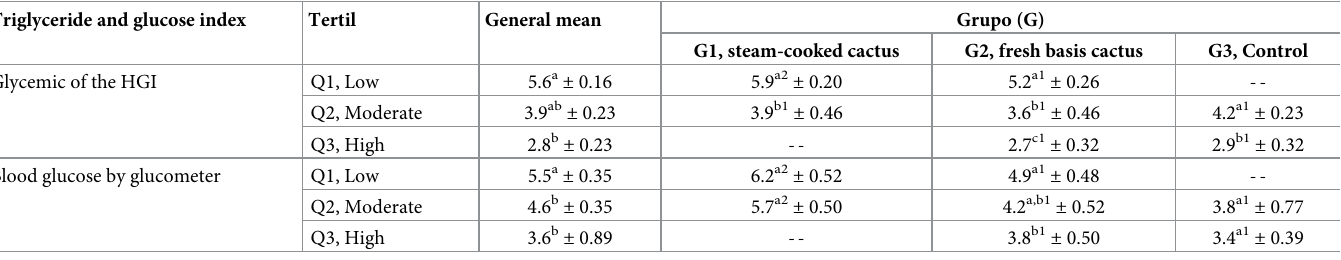
� = Commercial feed plus cactus consumption: fresh base cactus (0.529 ± 0.09 kg per sow per day), steam-cooked cactus (1.305 ± 0.09 kg per sow per day). Literals a, b indicate differences (p < 0.05) within the column for each interval. Numerals 1, 2 indicate differences (p < 0.05) between groups within the row.